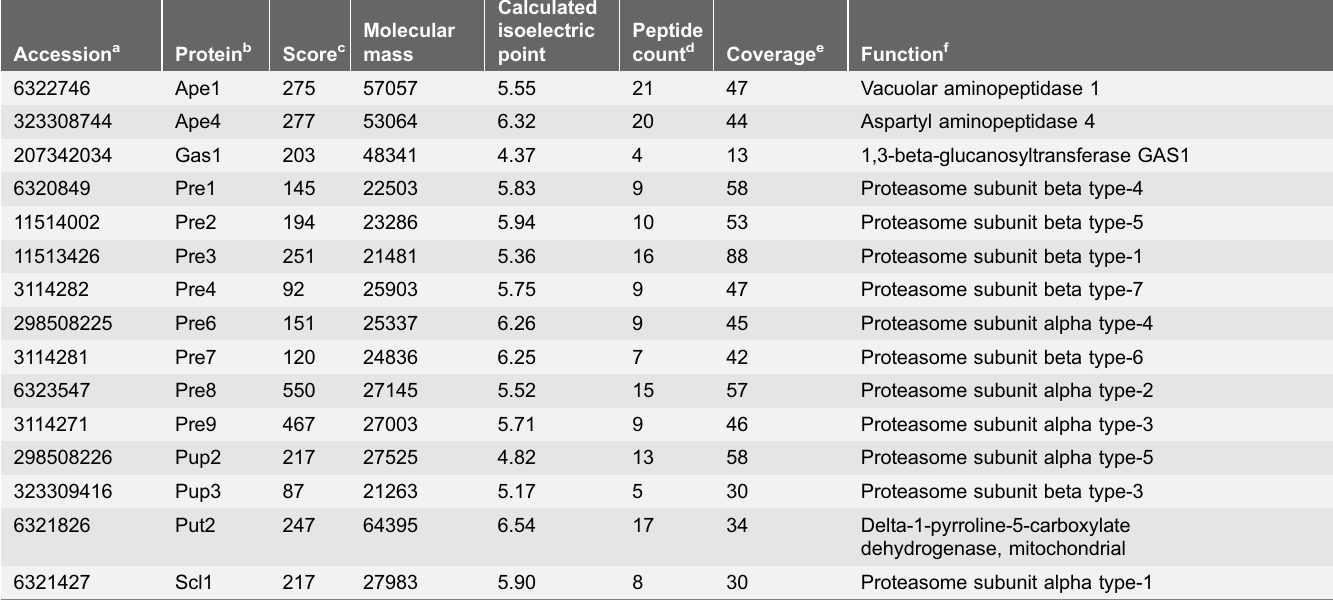
a GI number. b Standard abbreviations of protein names are indicated. c MASCOT protein score. d Number of unique peptides matched to mass peaks. e Sequence coverage in percent. f Data are presented in ‘‘Saccharomyces Genome Database’’